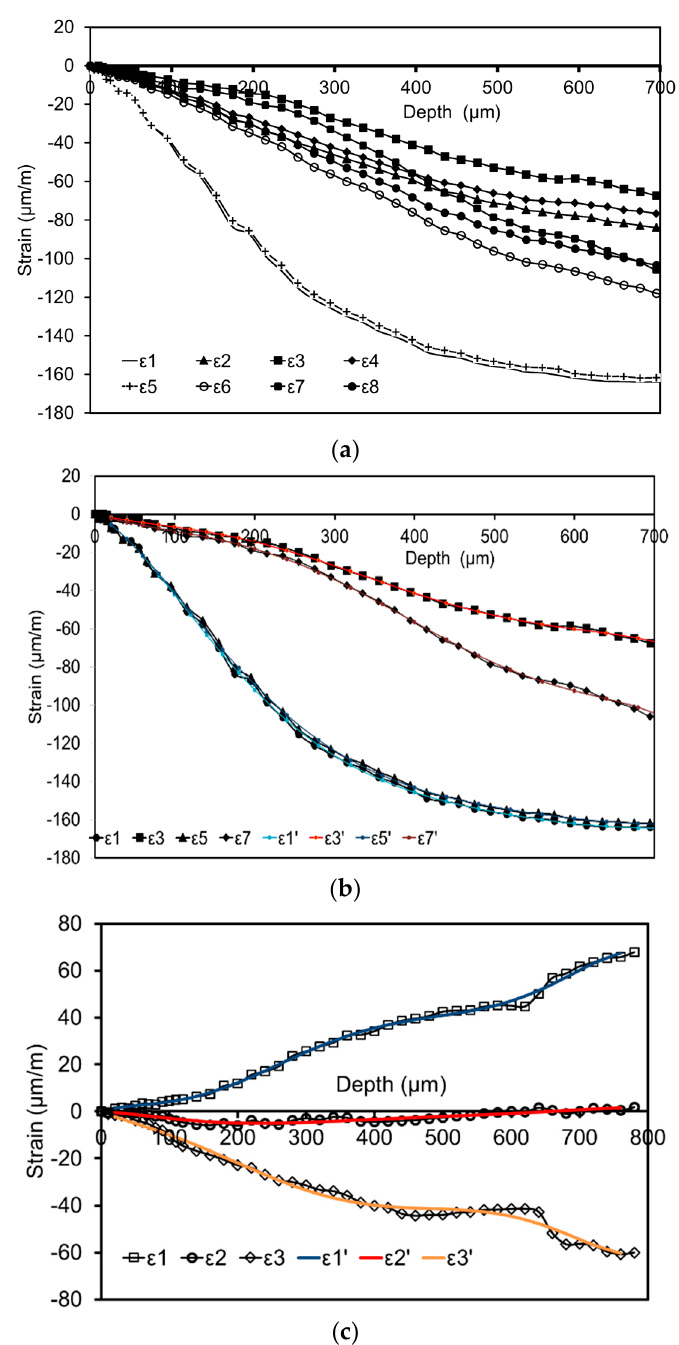
Figure 7. ( a ) Strain measurement on the side of the CFRP using a customized eight-grid strain gauge, ( b ) measured and approximated strains in the directions 1, 3, 5, 7 on the side of the CFRP and ( c ) measured and approximated strain on the side of the metal using a standard three-grid strain gauge (the approximated strains are highlighted by the colored lines).